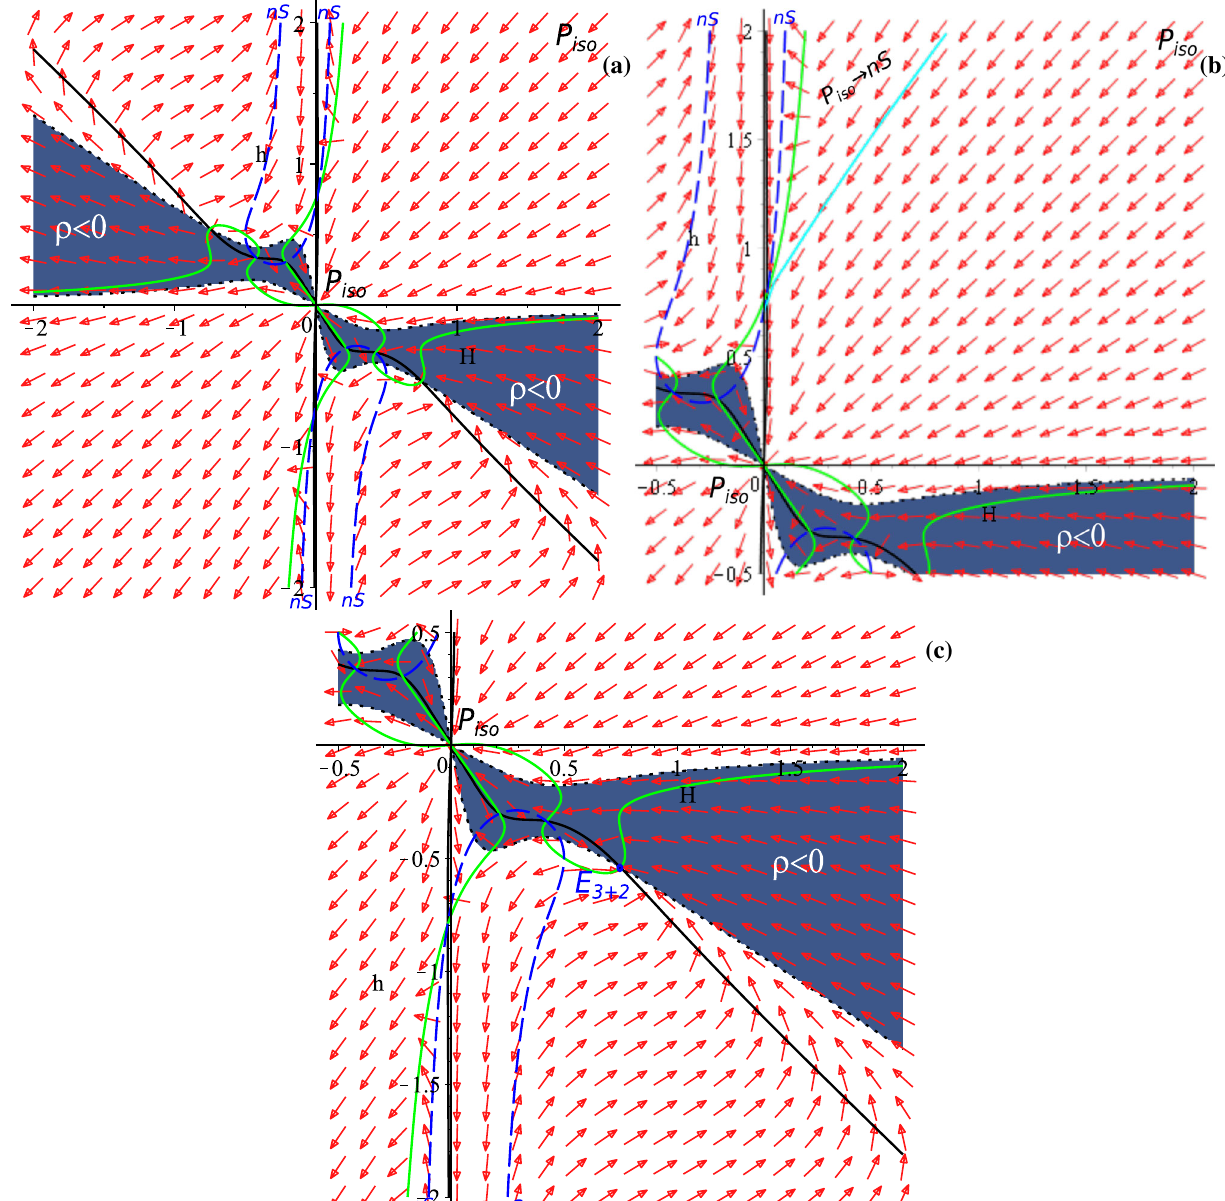
Fig. 6 Phase portraits for D = 2 α > 0, ω > 1 / 3 case: general view on a , focus on h > 0 regimes on b and focus on h < 0 regimes on c . Light blue line separate initial conditions leading to different regimes.